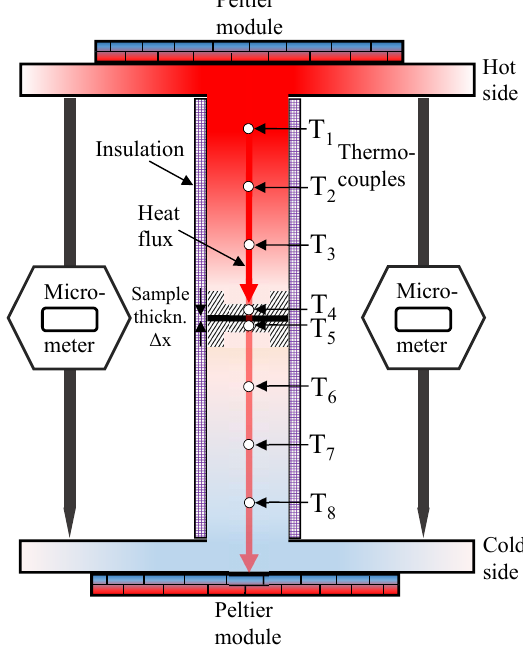
Figure 1. Sketch of the measurement